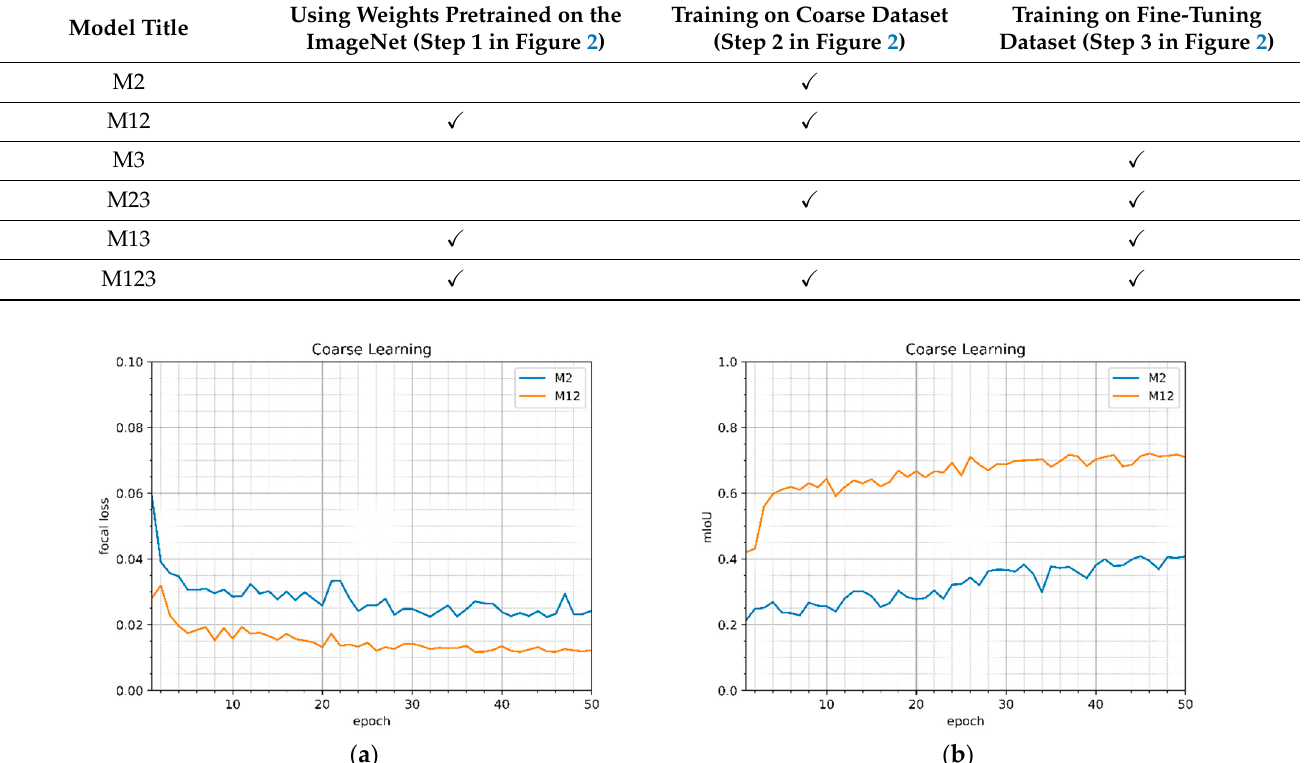
Figure 6. Evaluation metrics (focal loss ( a ) and mIoU ( b )) for coarse validation set during the coarse training of the models M2 (without pretraining on ImageNet) and M12 (with pretraining on ImageNet).